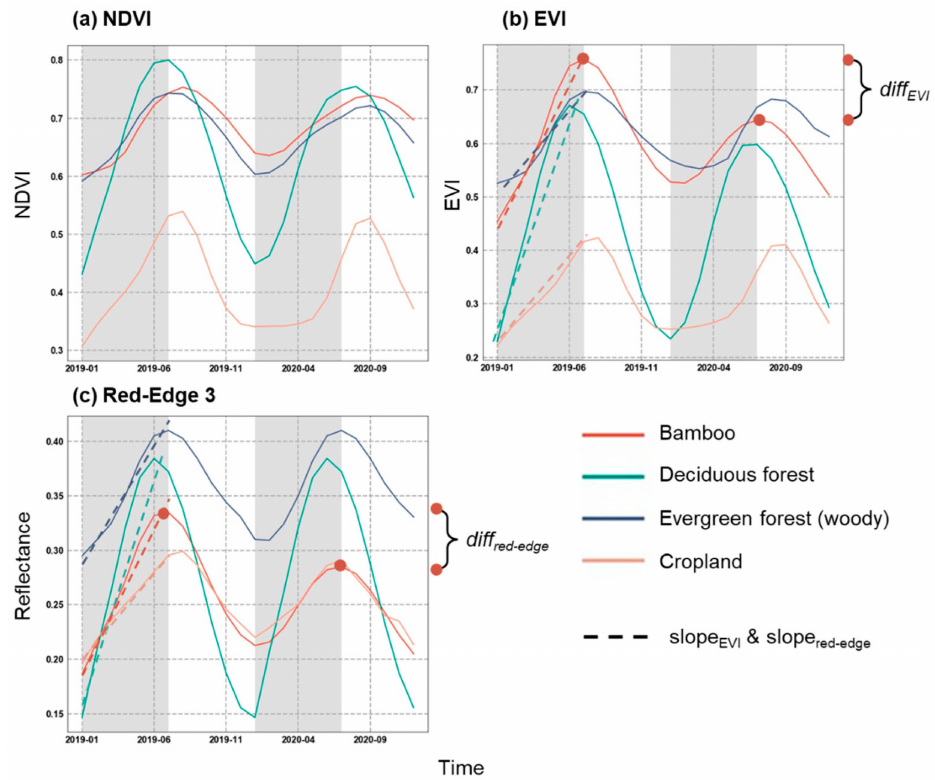
Figure 2. Example of time-series patterns for typical vegetation categories (bamboo, deciduous forest, evergreen woody forest and crop land). Solid lines in this figure represent the average of all field samples. The NDVI, EVI and red-edge reflectance from 2019 to 2020 are shown in panels ( a – c ), respectively. The difference in the peak value for the EVI and red-edge band ( dif f EVI and dif f red − edge ) is demonstrated in panels ( b , c ). The fitting slope for the red-edge reflectance in the green-up season (shade area) is demonstrated in panel ( c